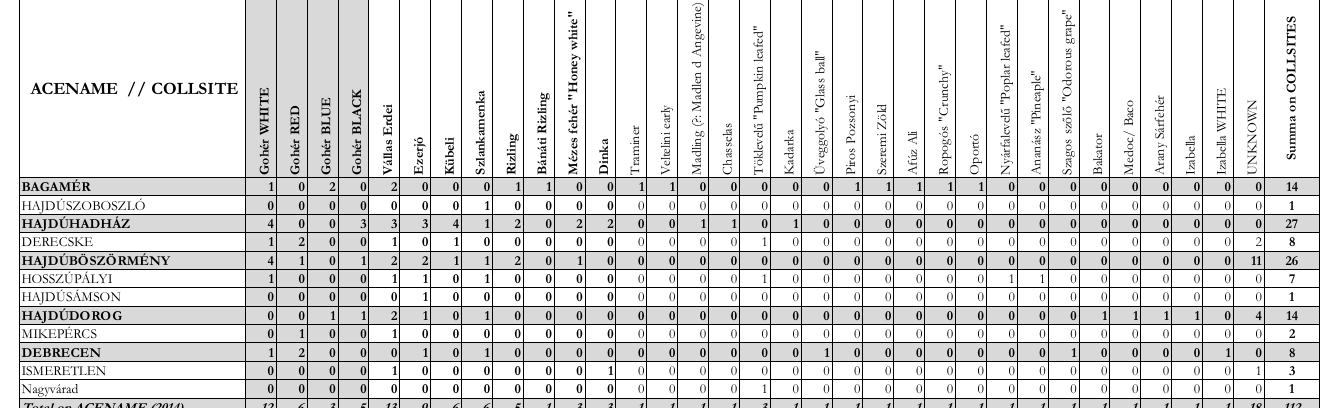
Table 2. Summary of ACENAME-s for each CALLSITE in 2014